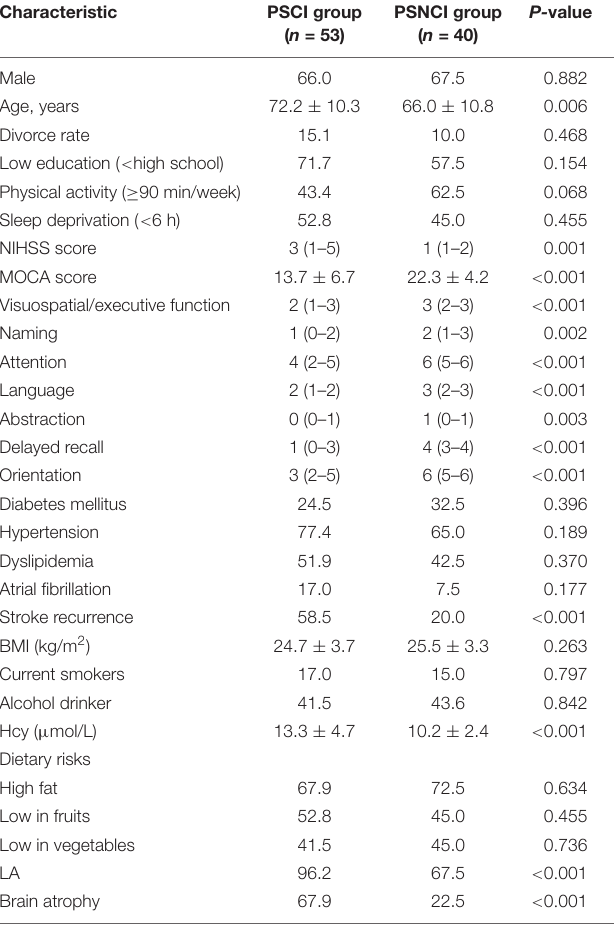
TABLE 1 | The significant differences of demographic and clinical parameters between PSCI and PSNCI groups.